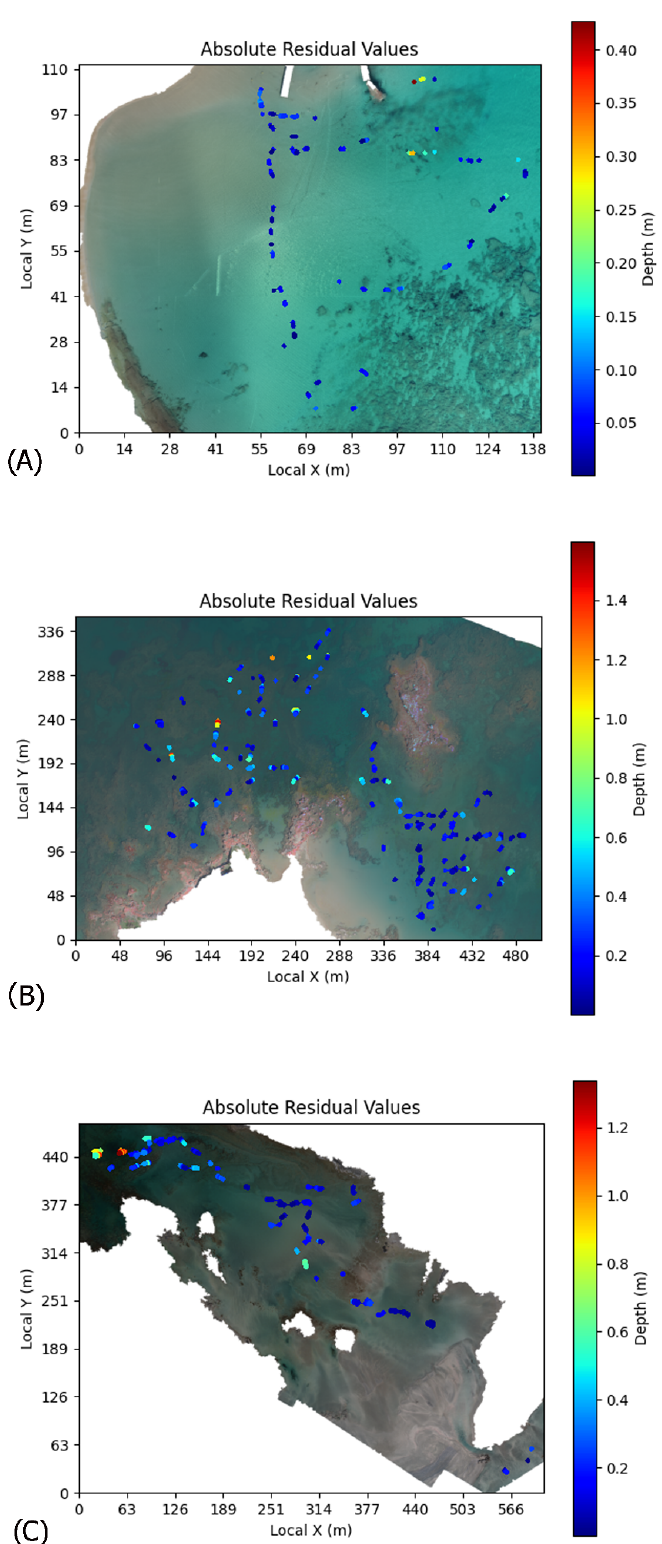
Figure 7. Spatial distribution of absolute depth residuals at each study area: ( A ) Stavros bay, ( B ) Kalamaki beach, ( C ) Elafonisi beach.